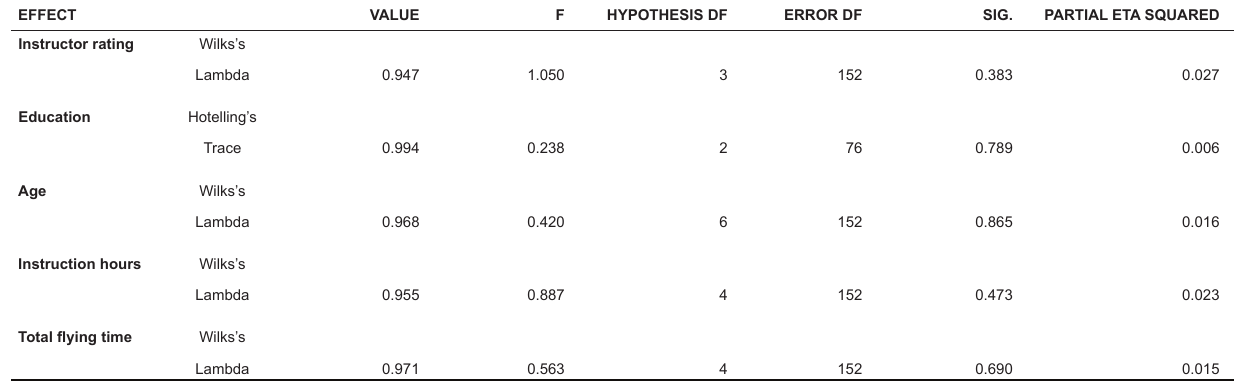
TABLE 5 MANOVA of flying proficiency and safety orientation with instructors’ biographical characteristics as independent